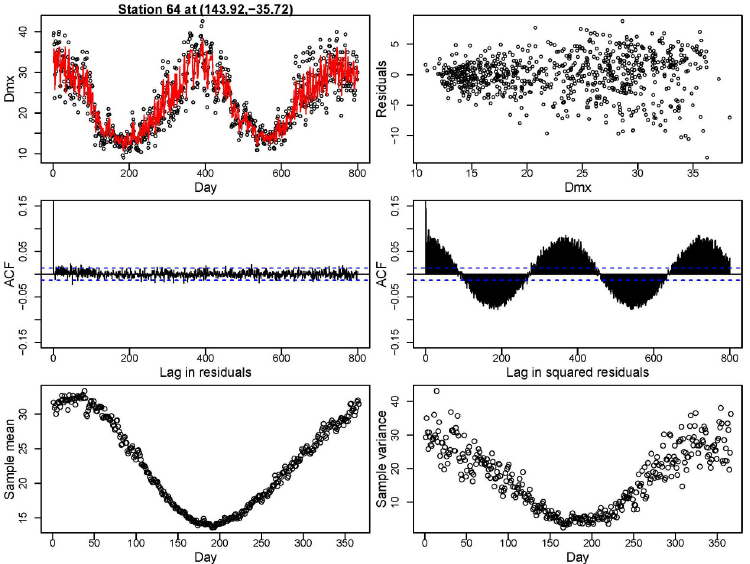
Fig 2. Exploratory analysis for a single station. Top left: fitting parametric mean model for Dmx. Top right: residuals of fit against predicted Dmx for the parametric mean model. Middle left: Auto-Correlation Function (ACF) plot for residuals for lag up to 800 days. Middle right: ACF plot for squared residuals for lag up to 800 days. Bottom left: sample mean over 60 years. Bottom right: sample variance over 60 years.